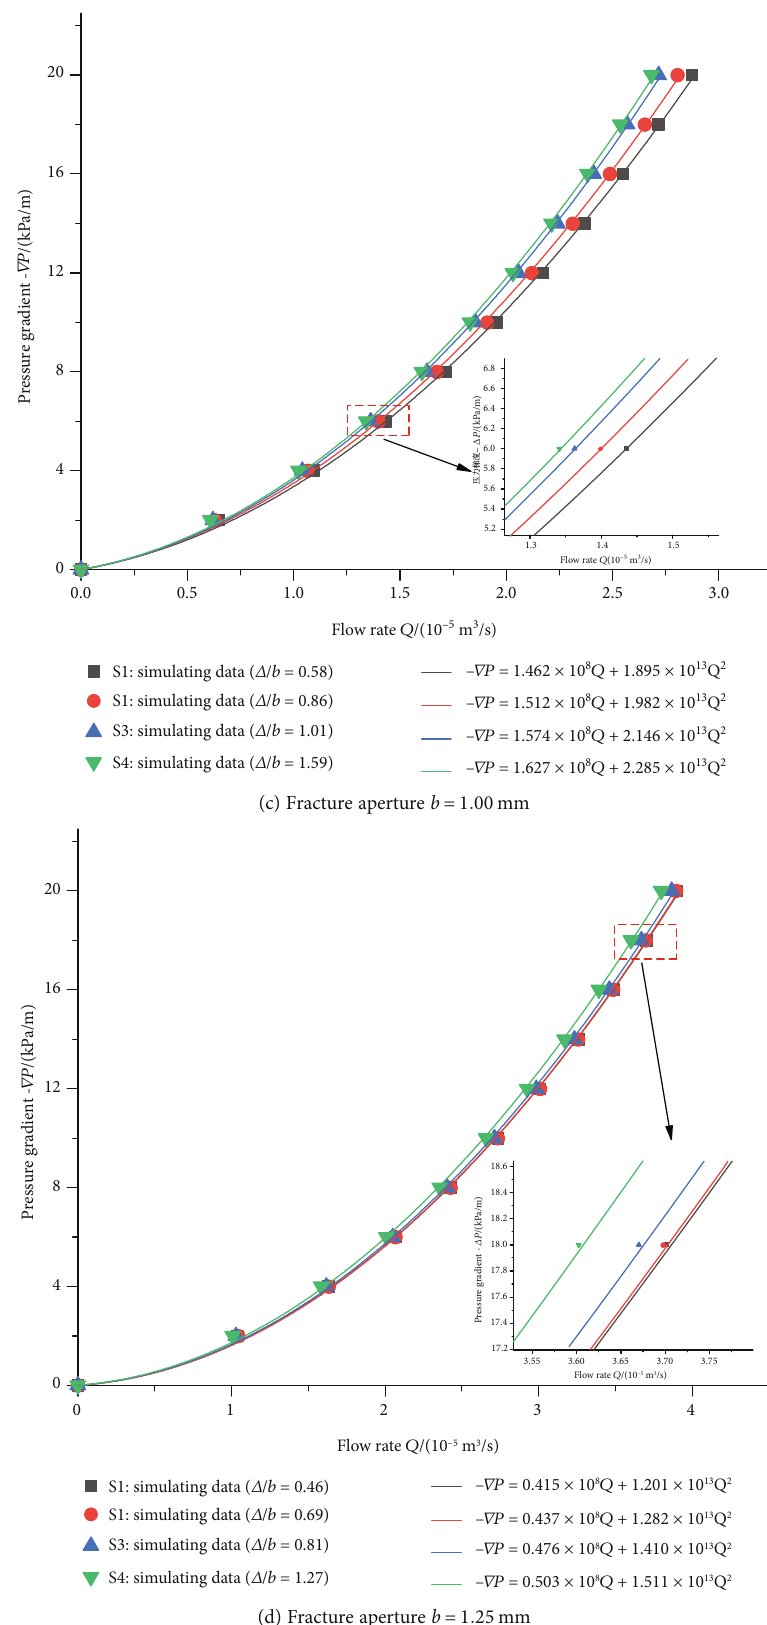
Figure 15: Curves of ∇ P and Q considering the variation of the hydroaperture for